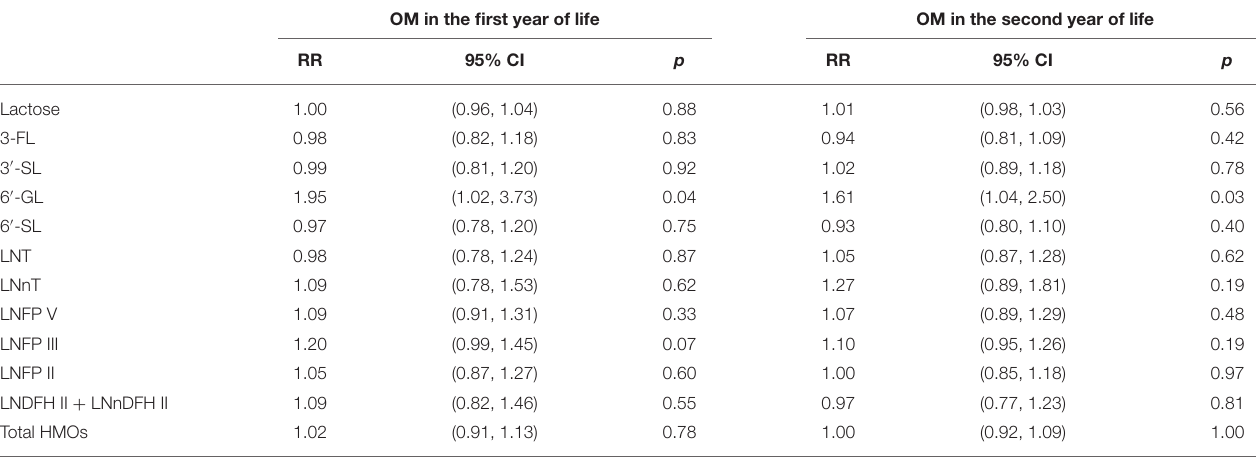
LNFP II 1.05 (0.87, 1.27) 0.60 1.00 (0.85, 1.18) 0.97 LNDFH II LNnDFH II 1.09 +